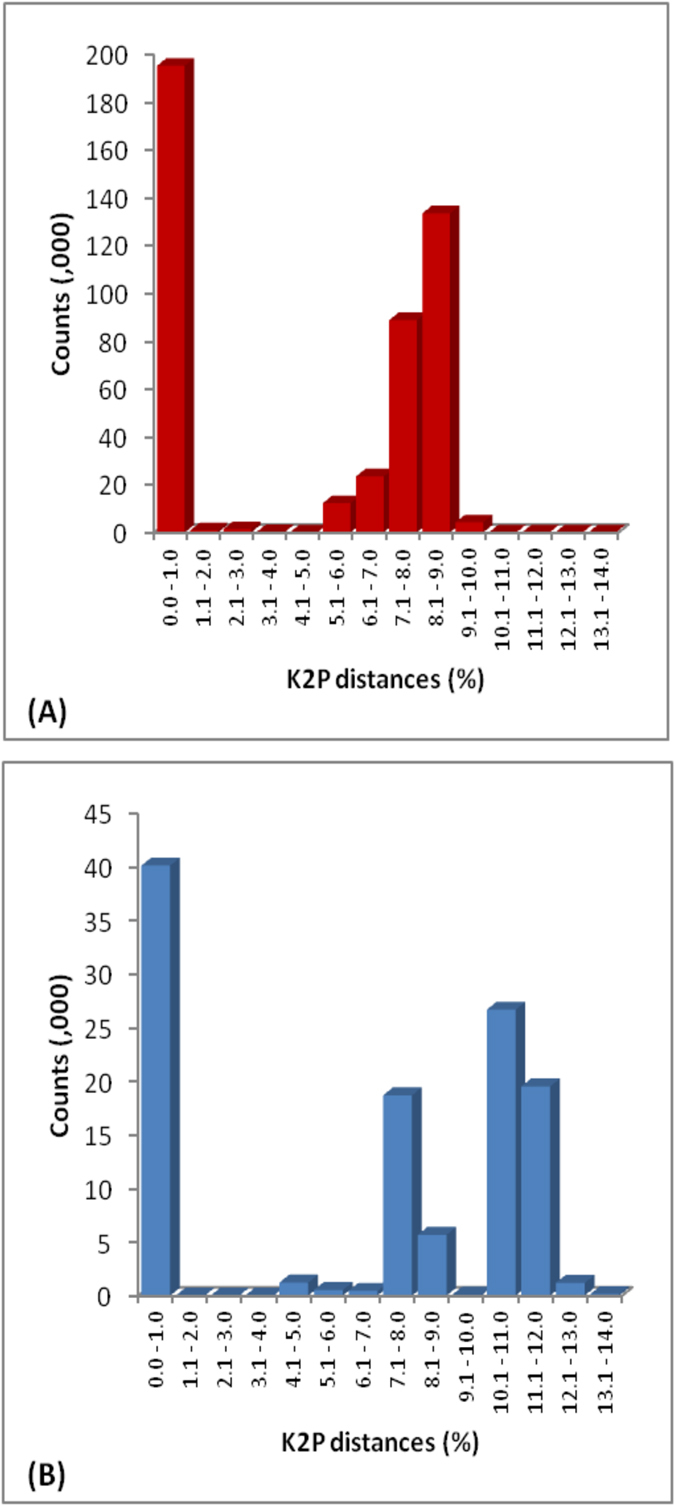
Histograms of pairwise (K2P) distances among 960 COI (A) and 479 cytb (B) sequences from head lice.